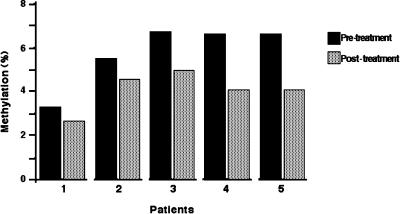
Global DNA methylation.The five patients had a reduction in 5mC content varying from 0.7−2.59% decrease. The mean 5mC in the five pre-treatment samples was 5.71% (standard deviation [SD], 1.43) which decreased to 4.2% (SD, 0.95). This difference was statistically significant (p = 0.043).